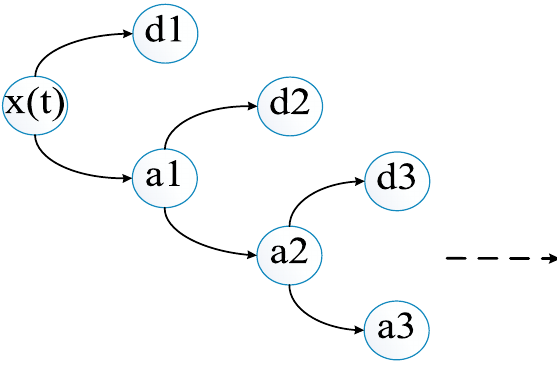
Figure 3. The Mallet decomposition algorithm.